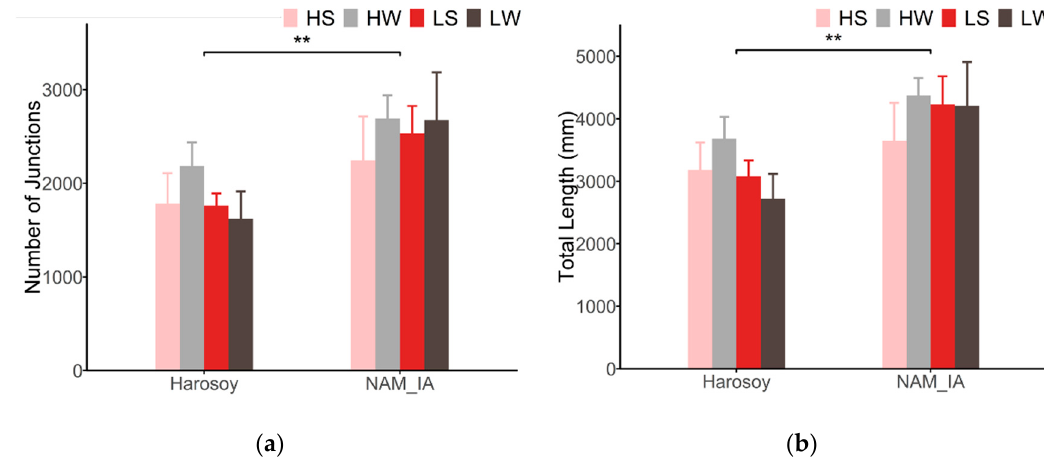
Figure 12. Leaf venation difference between groups. ( a ) Number of venation junctions (P < 0.01 for genotype, P = 0.746 for N, P = 0.378 for water by three-way ANOVA). ( b ) Total length of leaf venation (P < 0.01 for genotype, P = 0.618 for N, P = 0.524 for water by three-way ANOVA)). Data are represented as mean ±SE (n = 5). **P < 0.01 for genotype effect by three-way ANOVA. HS, high N and drought-stressed; HW, high N and well-watered; LS, low N and drought-stressed; LW, low N and well-watered.